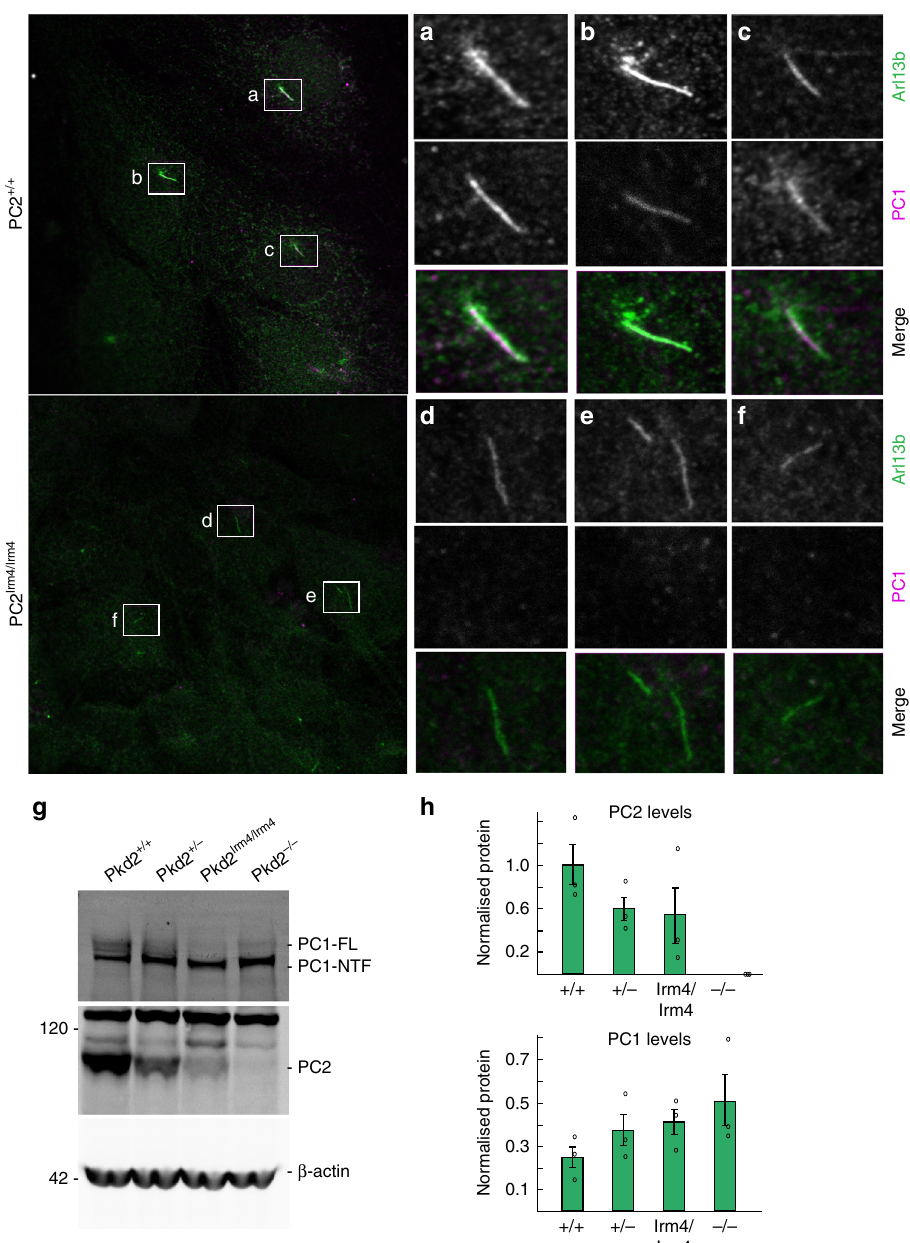
Fig. 5 PKD1 is not detected in the cilium in Pkd2 lrm4/lrm4 cells. In Wt MEFs, PKD1 localises along the length of the cilium. a – f enlarged from boxes in Merge on left. PC1 localises along the length of Wt cilia ( a – c ). In Pkd2 lrm4/lrm4 mutant cells, PC1 ciliary localisation is no longer observed. g Western blot analysis of MEF samples probed with an N-terminal-directed PC1 antibody and an antibody directed against PC2. β -Actin serves as a loading control. h Densitometry of PC1 and PC2 bands normalised to β -actin is represented as graphs. Error bars represent SEM. See source data for densitometry values presented in